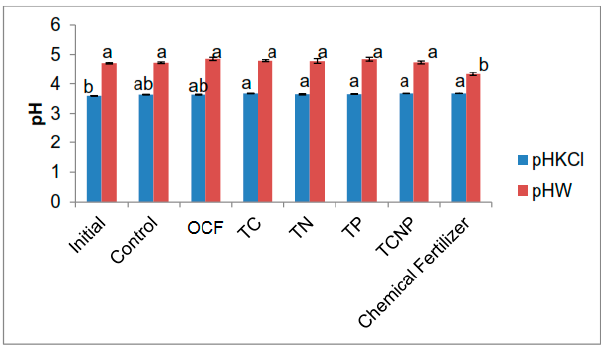
Figure A1. Effect of treatments on soil pH in KCl and water at fifty-six days after sowing. Different letters for similar colored bars indicate significant difference between treatment means using Tukey’s test at P ≤ 0.05.